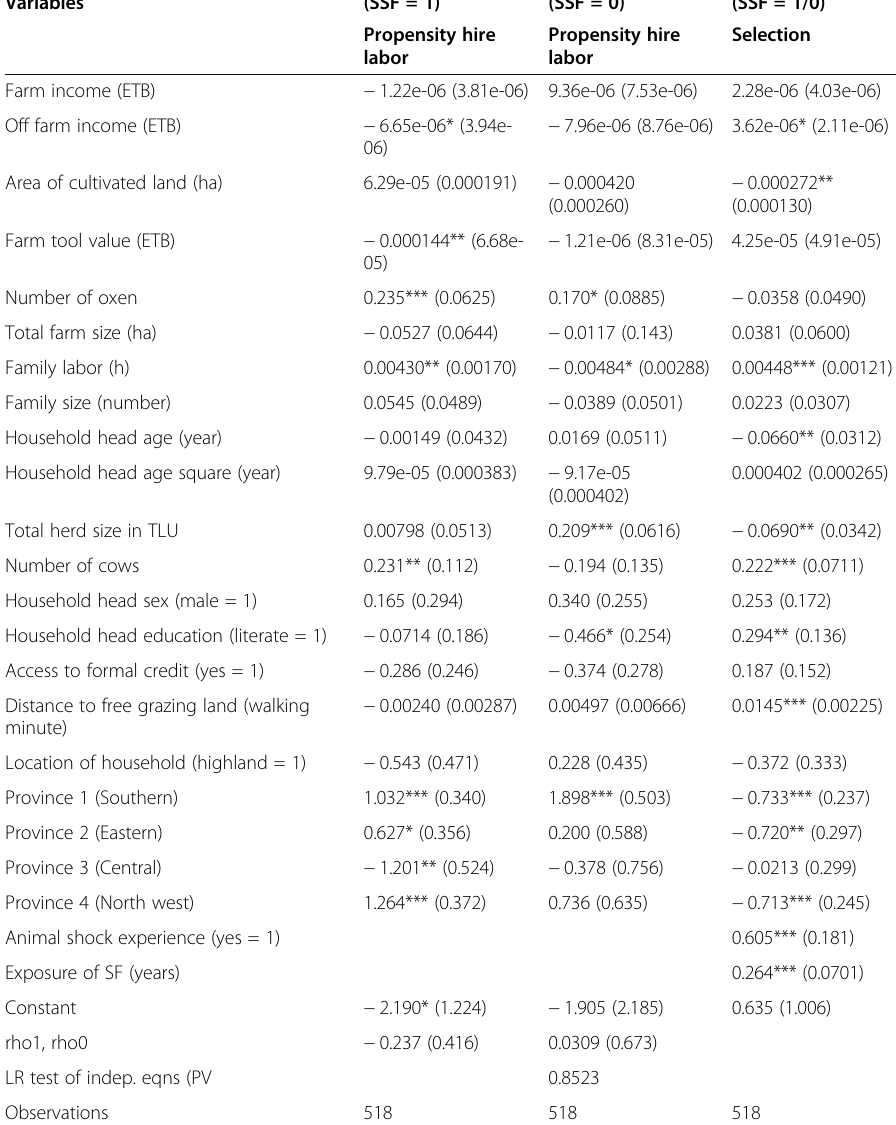
Table 7 Endogenous switching for FSF adoption and input use